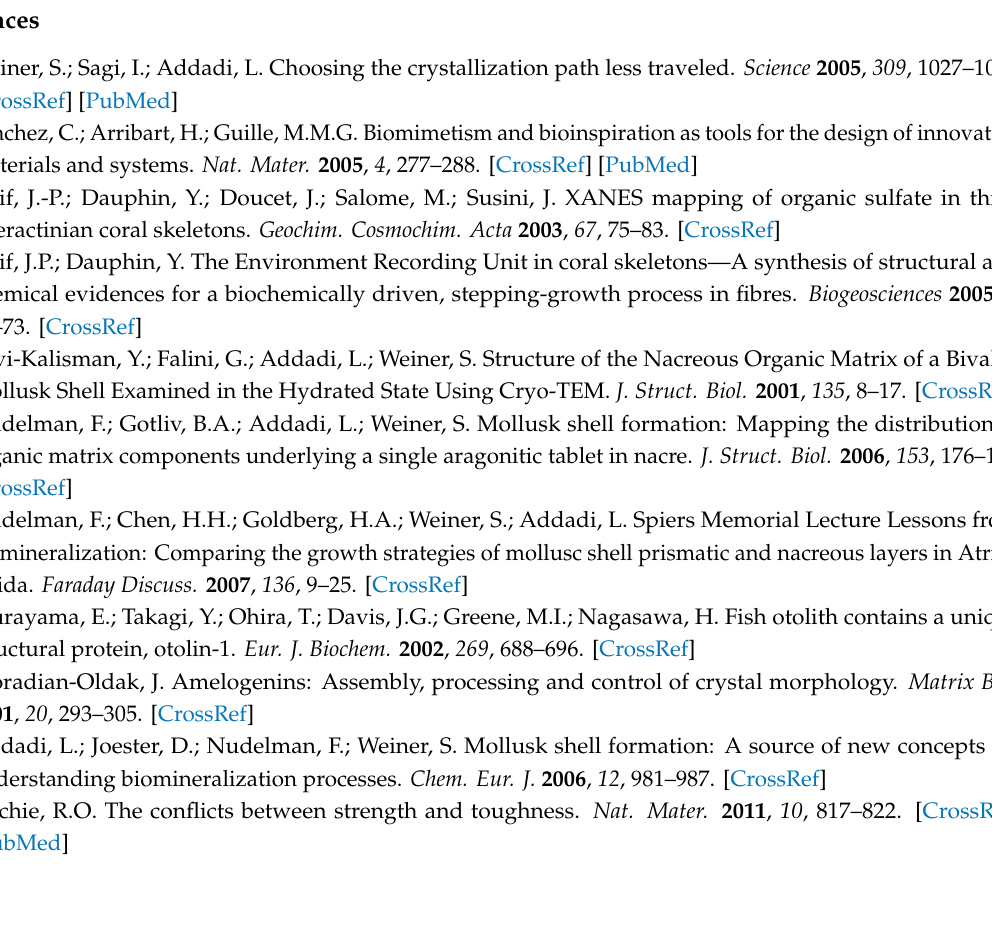
Figure S1: POM image showing the seed layer deposited on amorphous silk fibroin matrices. Figure S2: POM image showing the deposition of discontinuous CaCO 3 -SF hybrid films in 6 wt% SF hydrogels. Figure S3: POM image showing the deposition of rhombohedral single crystals on the seed layer in the absence of monomeric SF as additives. All authors have read and agreed to the published version of the